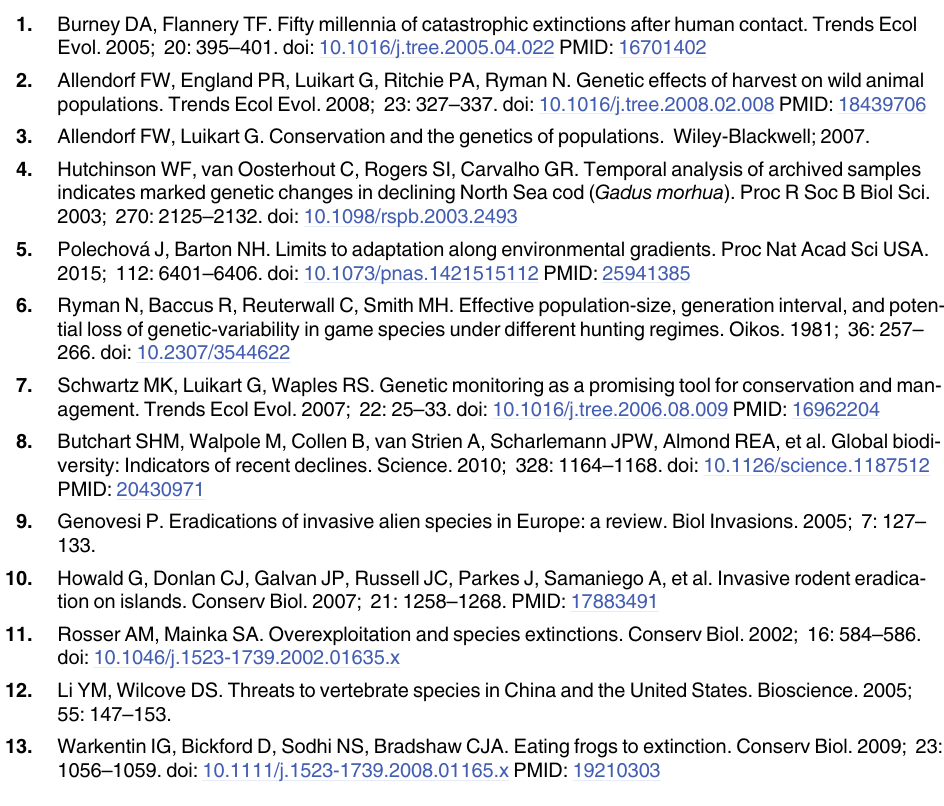
S2 Table. The average proportion of membership for the clusters identified by STRUC- TURE and DAPC compared with the sample site of American mink in Sweden N — number of mink analysed. Average membership higher than 0.4 is shown in grey